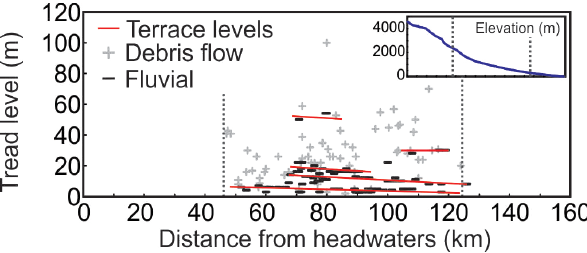
Figure 3. Locations of terraces along the Pisco river. The majority of terraces are concentrated in the zone from ∼ 50 to 120km down- stream. Inset shows the location of the terraces (dashed lines) along the river profile.